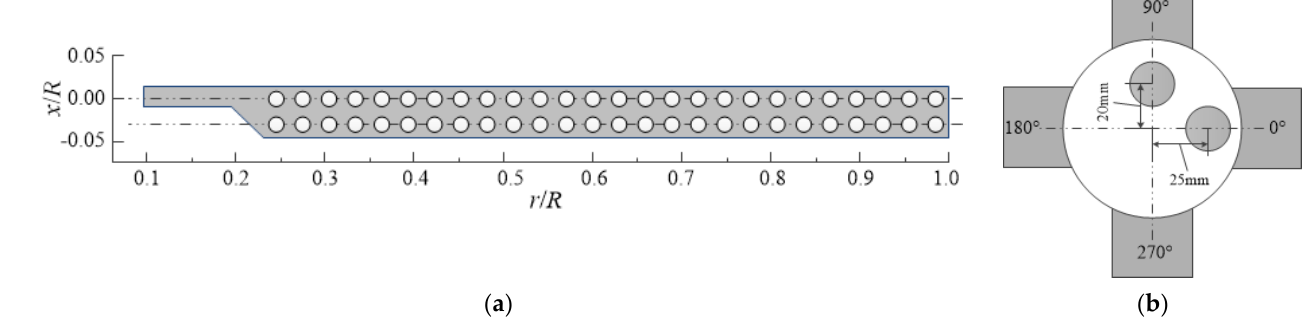
Figure 4. Distribution of ( a ) the blade targets and ( b ) the hub targets.